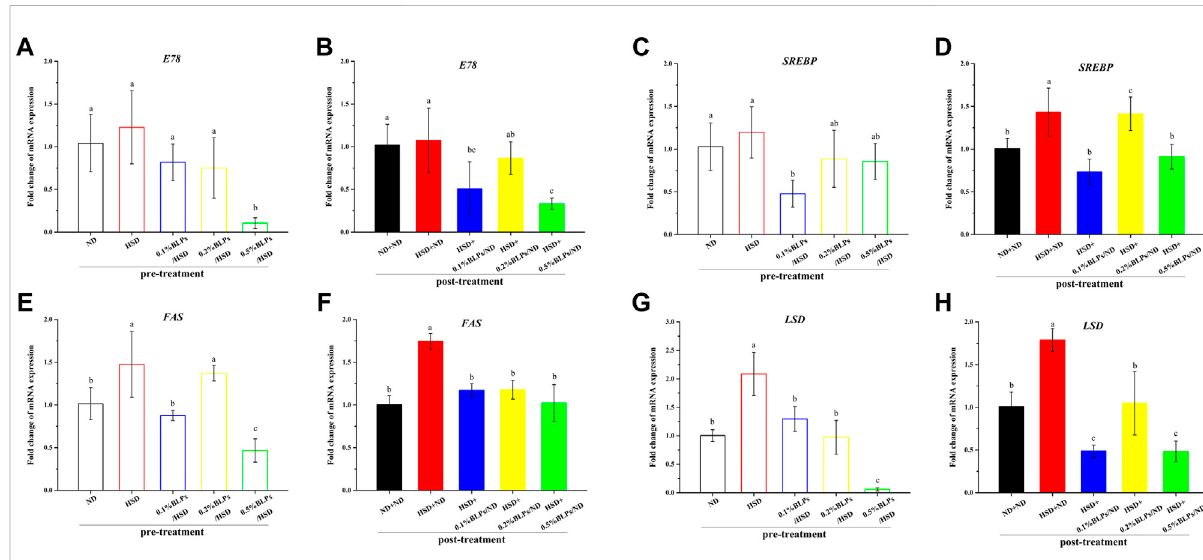
FIGURE 7 mRNA expression of main genes associated with lipid metabolism of those fl ies fed on media containing BLPs at different concentrations. Values with different letters (A – H) represent signi fi cant differences among the groups ( p <